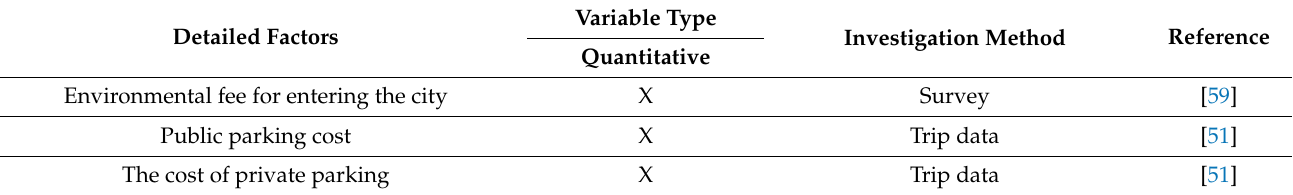
Table 4. Costs of using the urban transport system for users of individual